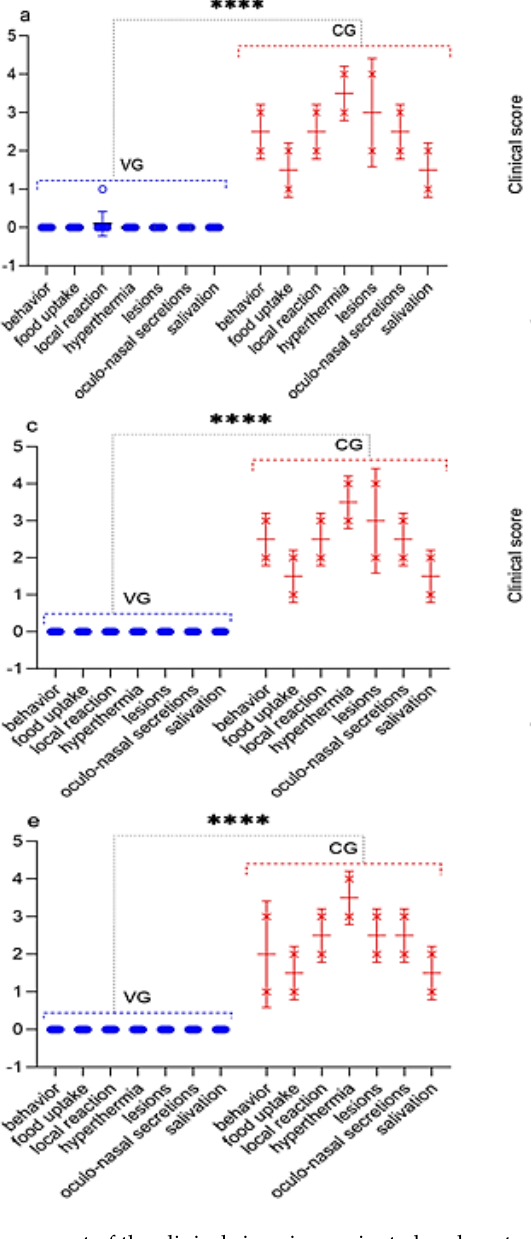
Figure 9. Assessment of the clinical signs in vaccinated and control sheep after infection with virulent SPPV. ( a ) Challenge 30 dpv. ( b ) Challenge 90 dpv. ( c ) Challenge 180 dpv. ( d ) Challenge 270 dpv. ( e ) Challenge 360 dpv. VG vaccinated group infected with virulent SPPV ( n = 10). CG control group infected with virulent SPPV ( n = 2). Data are means ± standard errors; **** р < 0.0001.